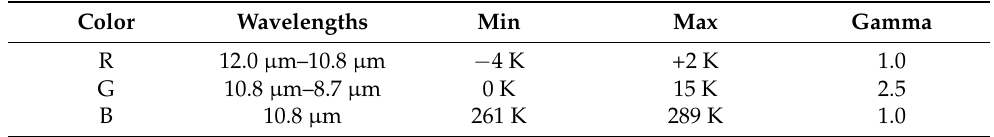
Figure 9. The VIIRS false-color RGB images of 14–17 March 2021. ( a ) 14 March 2021; ( b ) 15 March 2021; ( c ) 16 March 2021; ( d ) 17 March 2021.